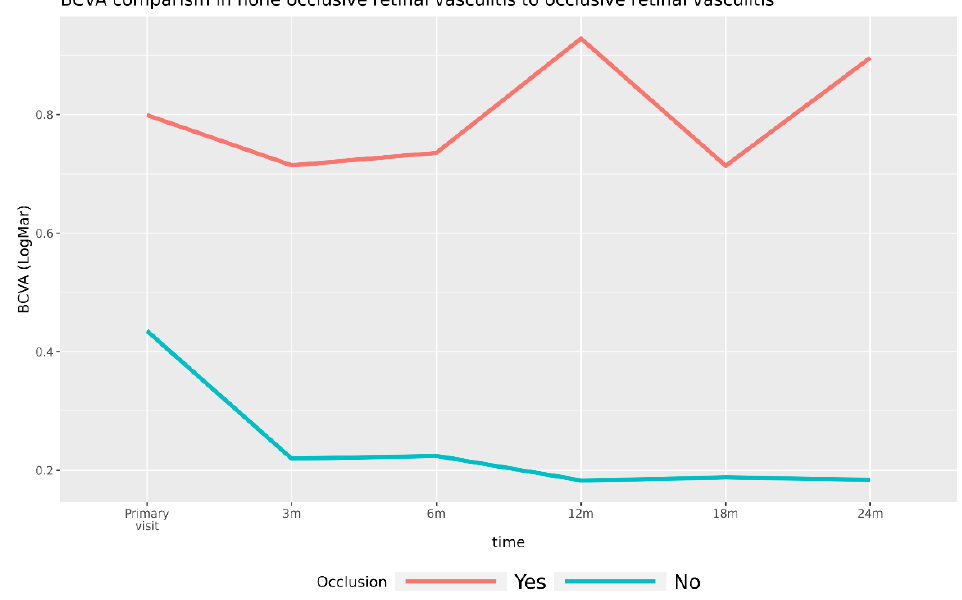
Figure 6. Shows the BCVA in patients with nonocclusive retinal vasculitis (green line) compared patients with occlusive retinal vasculitis (red line). The cases with occlusion have worse vision trajectory. The overall difference was significant, F (1,28) = 7.96, p = 0.012, where cases with occlusion had overall worse vision. Furthermore, they have negative changes compared with cases without occlusion (interaction, p = 0.0092). The data were analyzed with the ANOVA method. All postoperative intervals were significantly different to baseline in cases with no occlusion, p < 0.05. No significant change was observed in the group with occlusion, p > 0.05. Baseline BCVA in the nonocclusion group was 0.435 (Std. error. 0.18) and in the occlusion group, 0.8, p = 0.103. The differences between the groups at postoperative visits were all significant, with occlusion group having worse vision, p < 0.05. (Note: Due to some severe cases, we also repeated the analysis with robust estimation. The trend of the occlusion group having worse vision was confirmed by this method as well. The difference at baseline, which lacked statistical significance, was found significant using robust approach).